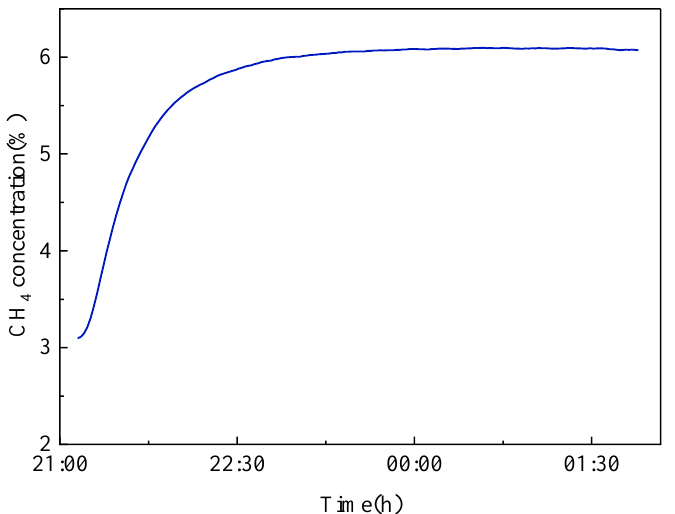
Figure 9. In situ measurement of dissolved CH 4 at the Haima Cold Spring Area in the South China sea.